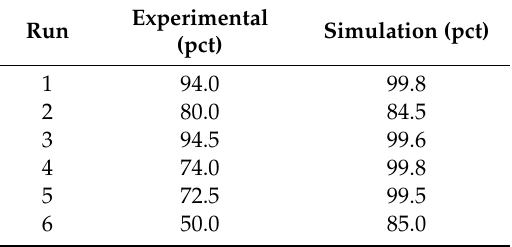
Table 6. Experimental vs. computed reduction degrees.